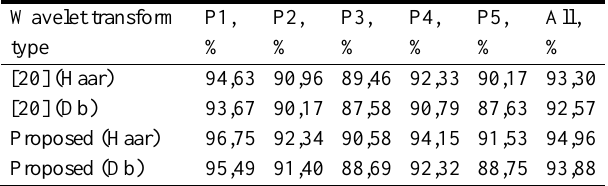
Table 1. Accuracy rate of hand pose classifying